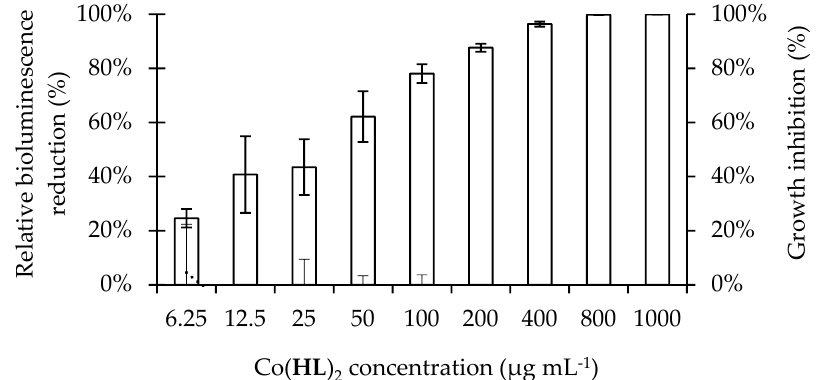
Figure 1. Effect of increasing concentrations of Co( HL ) 2 (6.25 to 1000 µ g mL − 1 ) on P. aeruginosa 3-oxo-C12-HSL-dependent QS system (bars) in general and on growth inhibition (dashed line) (based on the co-culture of wild-type/biosensor). Bioluminescence emissions were normalized to the cell density of the bacterial culture and expressed as percentages with respect to untreated controls (cells + DMSO at 6%; relative bioluminescence). Mean values ± standard deviations for at least three replicates are illustrated.